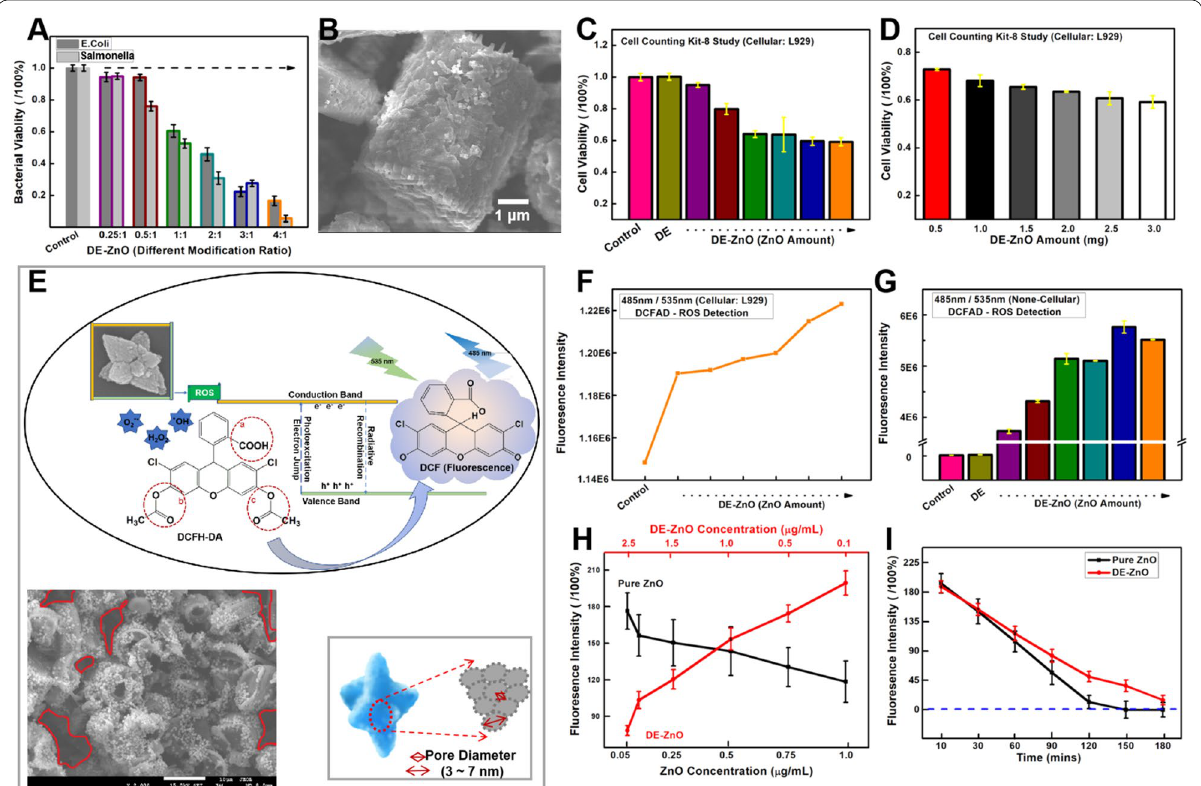
Fig. 2 Study the antibacterial activity and bio‑safety dosage of DE‑ZnO. A Antibacterial efficiency of DE‑No against Gram‑negative bacteria ( E. coli, S. enterica ) at a concentration of 10 µg/mL. B SEM image showing the surface of DE‑ZnO composites after meeting/absorbing pathogen. C Cell viability study of the cytotoxicity of DE‑ZnO at different modification ratios with dosage of 0.25 mg in one hole through Cell counting Kit 8 method. D Dosage depended cytotoxicity study of DE‑ZnO (ZnO: DE 2:1, 10.61% of ZnO), L929 cells were exposed to different doses (0.5–3.0 mg) for 24 h. = Each data value is mean SE of three independent experiments. E Schematic illustration of the Reactive oxygen species (ROS) detection, due to the ± band gap of semiconductor could absorb energy and release ROS which would transfer the DCFH‑DA to DCF (Fluorescence); inside the SEM image of DE‑ZnO confirmed that the well‑wash DE‑ZnO composites is without dispersed ZnO‑S (blank in red cycle); meanwhile the special multi‑pore morphology of ZnO‑S has been marked. F Cellular ROS detection assay using DE‑ZnO with different ratios of ZnO modification (ZnO:DE